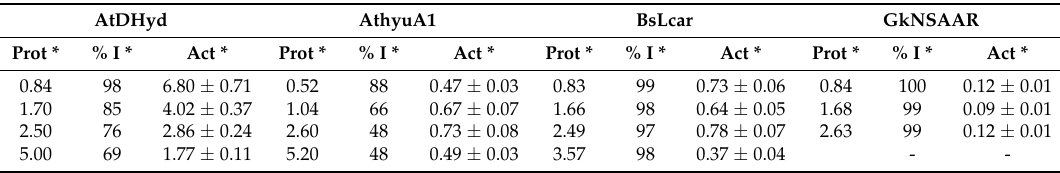
Table 1. Optimization of the quantity of protein necessary to saturate the attachment point of covalent binding to 400 mg of the support IB-350. Activity was measured using 10 mM D -ethylhydantoin for AtDhyd activity; 10 mM L -ethylhydantoin for hydantoin racemase from Agrobacterium tumefaciens C58 (AthyuA1) activity coupling with D -hydantoinase from Agrobacterium tumefaciens BQL9 (AtDHyd); 10 mM D -carbamoyl methionine for N -succinylamino acid racemase from Geobacillus kaustophilus (GkNSAAR) activity coupling with L - N -carbamoyl amino acid amidohydrolase from Geobacillus stearothermophilus CECT43 (BsLcar); 10 mM L -carbamoyl methionine for BsLcar activity. All reactions were carried out in the presence of 1 mM CoCl 2 , except for AthyuA1, 100 mM borate buffer pH 8, 60 ◦ C for 30 min with constant stirring. The compounds were separated by HPLC water with a Zorbax C 18 column, mobile phase of 80:20 20 mM phosphoric acid, pH 3.2, and methanol, 0.4 mL/min, and measurement at λ = 203 nm.